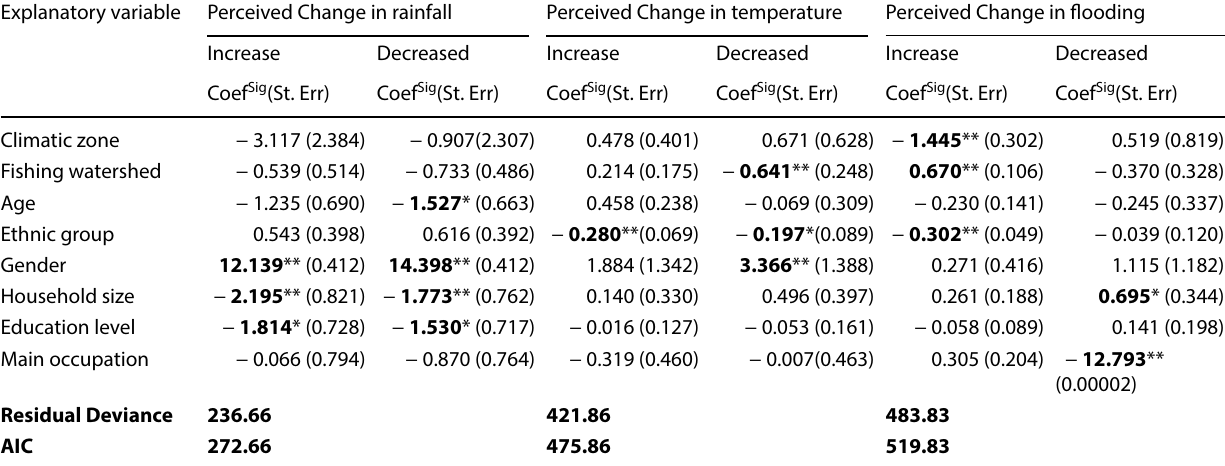
Significant correlations in bold, with level of significance indicated by stars, and standard errors in brackets * α < 0.05; ** α